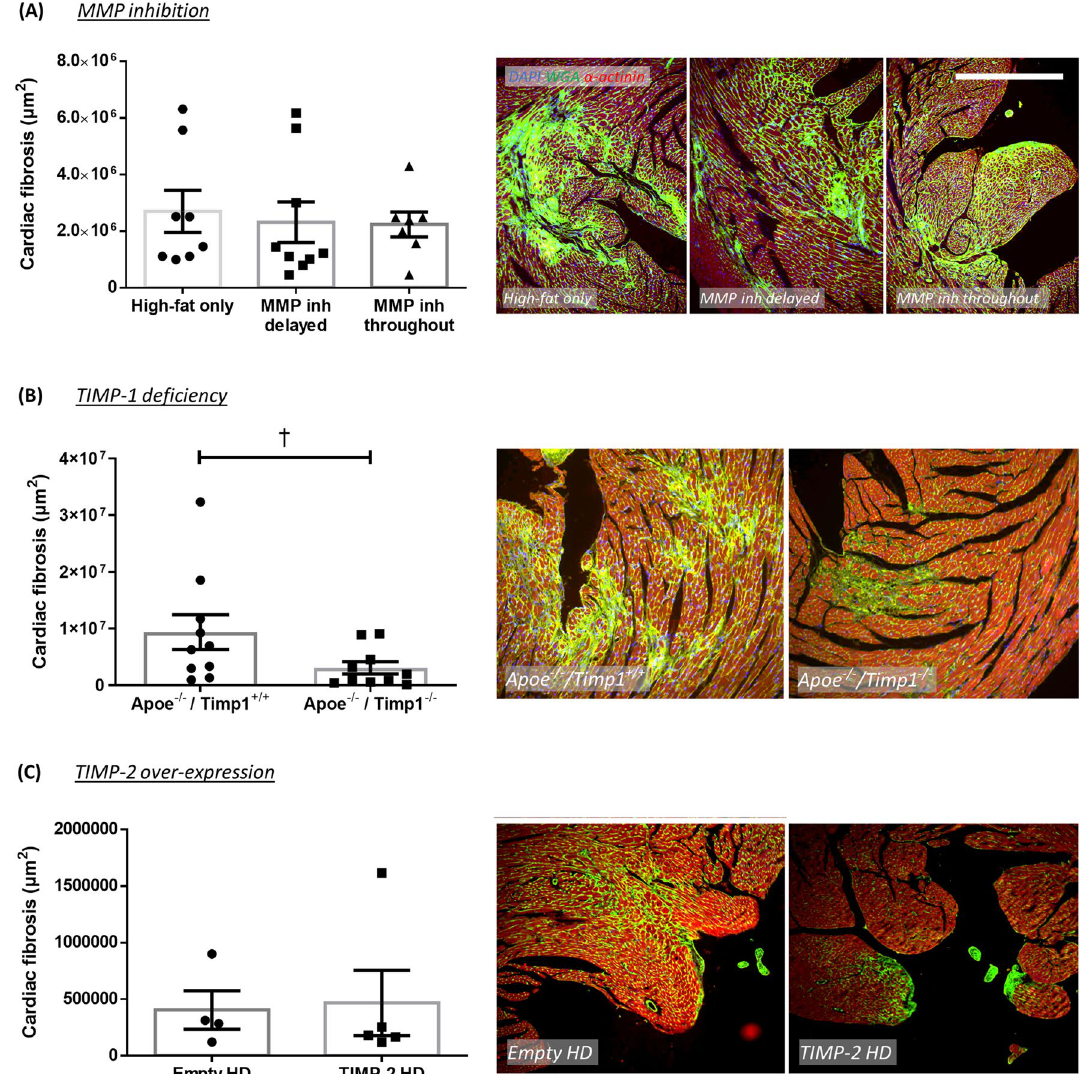
Figure 6. Effect of MMP inhibition and TIMP modulation on cardiac fibrosis in apolipoprotein E-deficient (Apoe -/- ) mice. Quantification and representative images of cardiac fibrosis as assessed in WGA-stained hearts from ( A ) 36-week high-fat fed Apoe -/- mice treated with or without a broad-spectrum MMP inhibitor, ( B ) 36-week high-fat fed Apoe -/- mice deficient for TIMP-1 in comparison to Apoe single knockout controls, and ( C ) 18-week high-fat fed Apoe -/- mice with administration of a TIMP-2 helper-dependent (HD) adenovirus or an empty HD as control. Cardiac fibrosis is presented as average fibrillar collagen content (green) in µm 2 / heart cross-section/mouse. Statistical significance is reported as † P < 0.05 using Mann–Whitney test. Scale bar represents 1 mm and is applicable to all panels. In A, n = 7–9/group; in B, n = 10/group; in C, n =